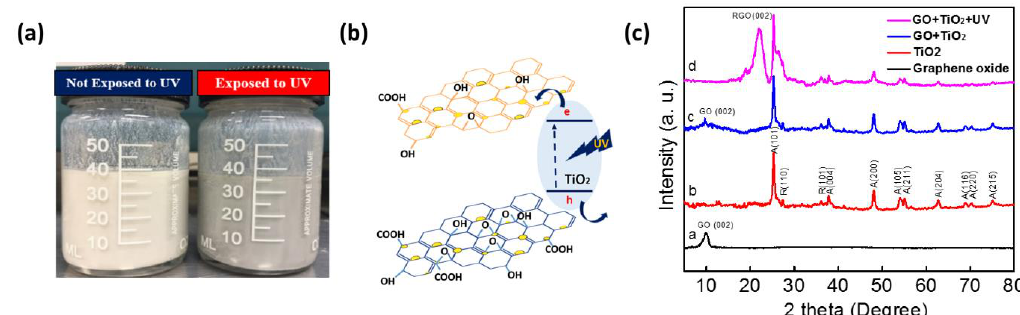
Figure 2. ( a ) The photograph of GO/TiO 2 composite before and after UV exposure. ( b ) The schematic diagram of GO/TiO 2 composite under the UV effect. ( c ) XRD spectra of the prepared (a) GO, (b) TiO 2 , GO/TiO 2 composite (c) before, and (d) after UV exposure.